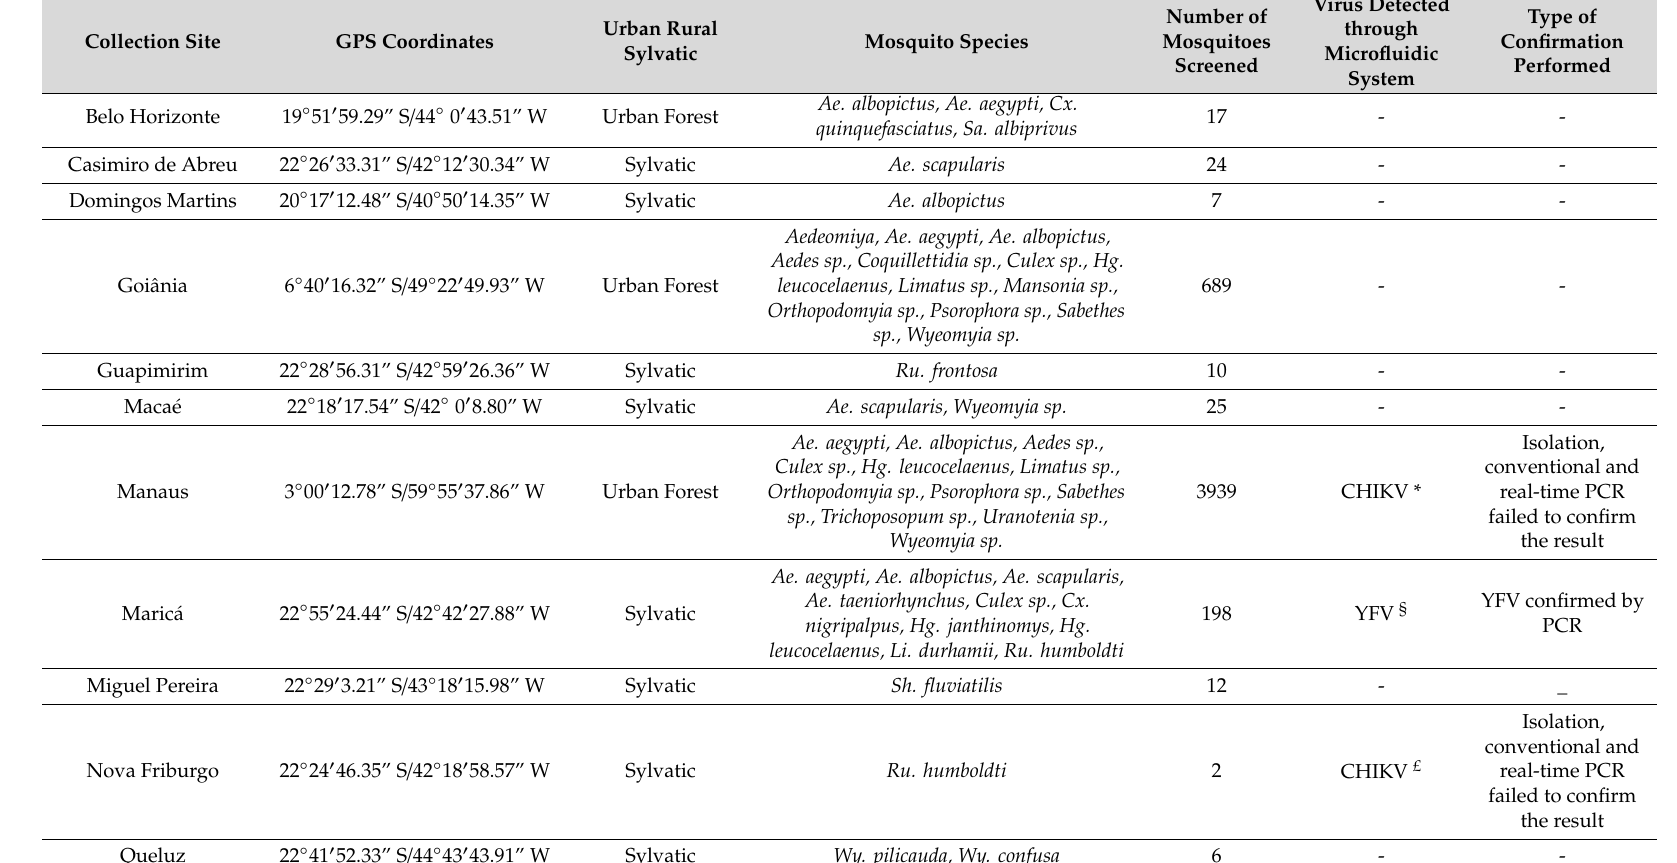
Table 3. Mosquito species, number of mosquitoes collected, and viruses detected in